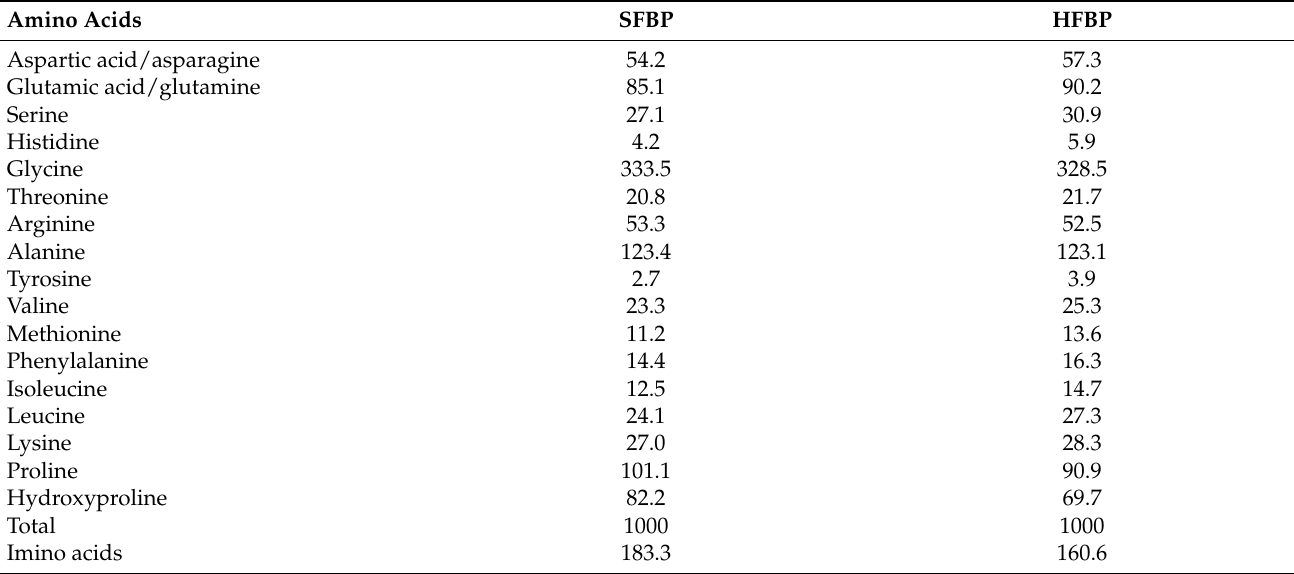
Table 1. Amino acid composition of fish bone protein treated by steam explosion-assisted extraction and hot-pressure extraction (results are expressed as residues/1000 total